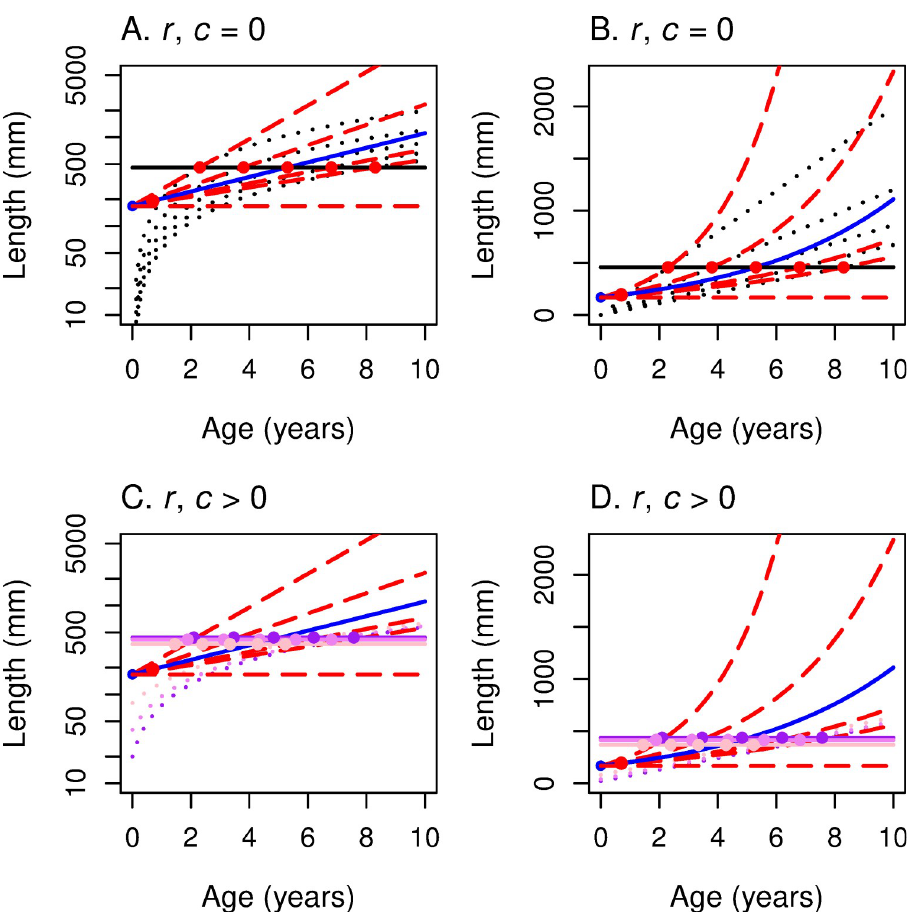
Fig 3. These panels illustrate the construction of the maturation reaction norm MRN( r ) for linear growth. For linear growth: L = c + k x , where L is length, x is age in years, k is the growth rate, and c the size at age 0. r is the underlying fitness function for all four panels. (A, C) The y -axis represents log-length so that the iso-fitness curves (red-dashed lines) are straight lines. (B, D) The y -axis represents linear length so that the growth curves (black dotted lines) are straight lines. Size c at x = 0 is set to 0 in the first row; c > 0 in the second row (purple: 20 mm; violet: 40 mm; pink: 80 mm). Higher growth curves correspond to higher values of the growth rate k . For each growth curve, one finds the highest iso-fitness curve that intersects it. The locus of such points as k varies traces out the reaction norm (solid black line for c = 0, colored horizontal lines for c > 0). The reaction norm is perfectly horizontal when r is the fitness function (versus mostly vertical when R 0 is the fitness function; Fig 2). Fig 4 summarizes and consolidates this